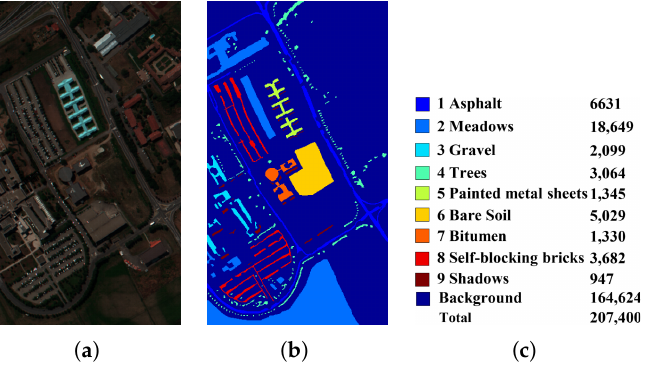
Figure 7. Pavia University imagery: ( a ) color composite with RGB bands (61,25,13), ( b ) ground truth, and ( c ) class names with available